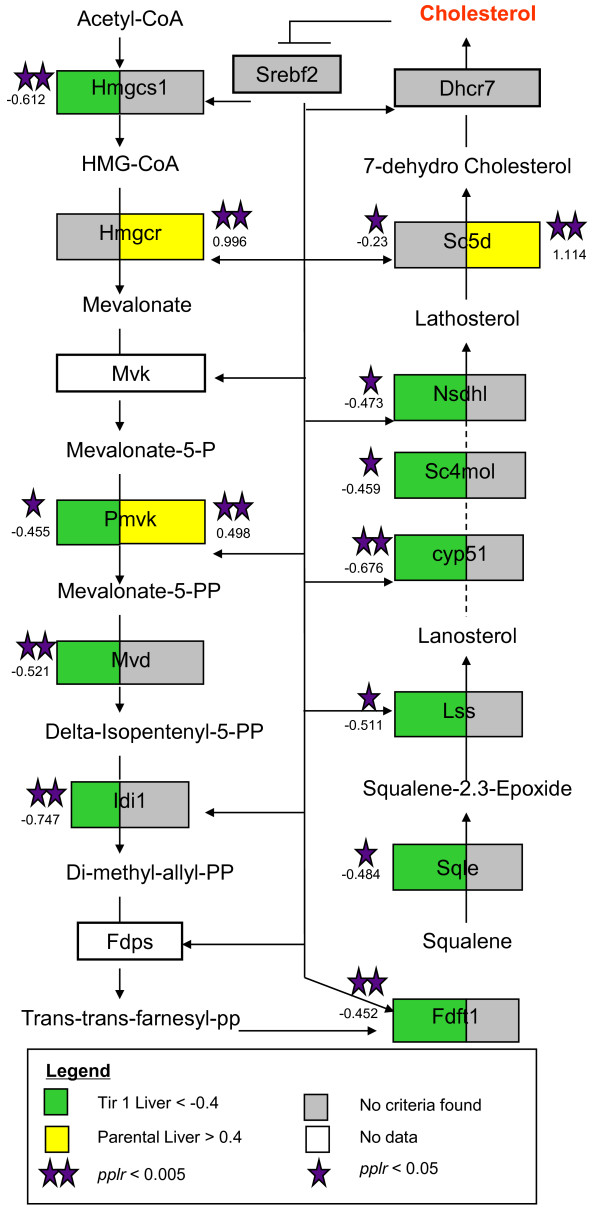
Cholesterol synthesis pathway compiled using GenMapp. Genes regulated by Srebf2 (Srebp2) from Reed et al. [33]. Ratio of Tir1CC to Tir1AA congenic mouse expression is shown on the left of each box and the ratio of C57BL/6 to A/J parental mouse expression is shown on the right of each box. Genes in green boxes have < -0.4 log2 expression ratio in the liver of the congenic mice, genes in yellow have > 0.4 log2 expression ratio in the liver of parental mice. Genes indicated by purple stars are significantly differentially expressed as indicated in the legend. Log2 expression ratios are shown by each gene where the absolute ratio > 0.4 or the ratio is significantly different from 0 as indicated by the stars. Negative log2 ratios indicate higher expression in mice carrying A/J alleles (A/J and Tir1AA) than mice carrying C57BL/6 alleles (C57BL/6 and Tir1CC). None of the genes in this pathway were differentially expressed in Tir3AA v Tir3CC.